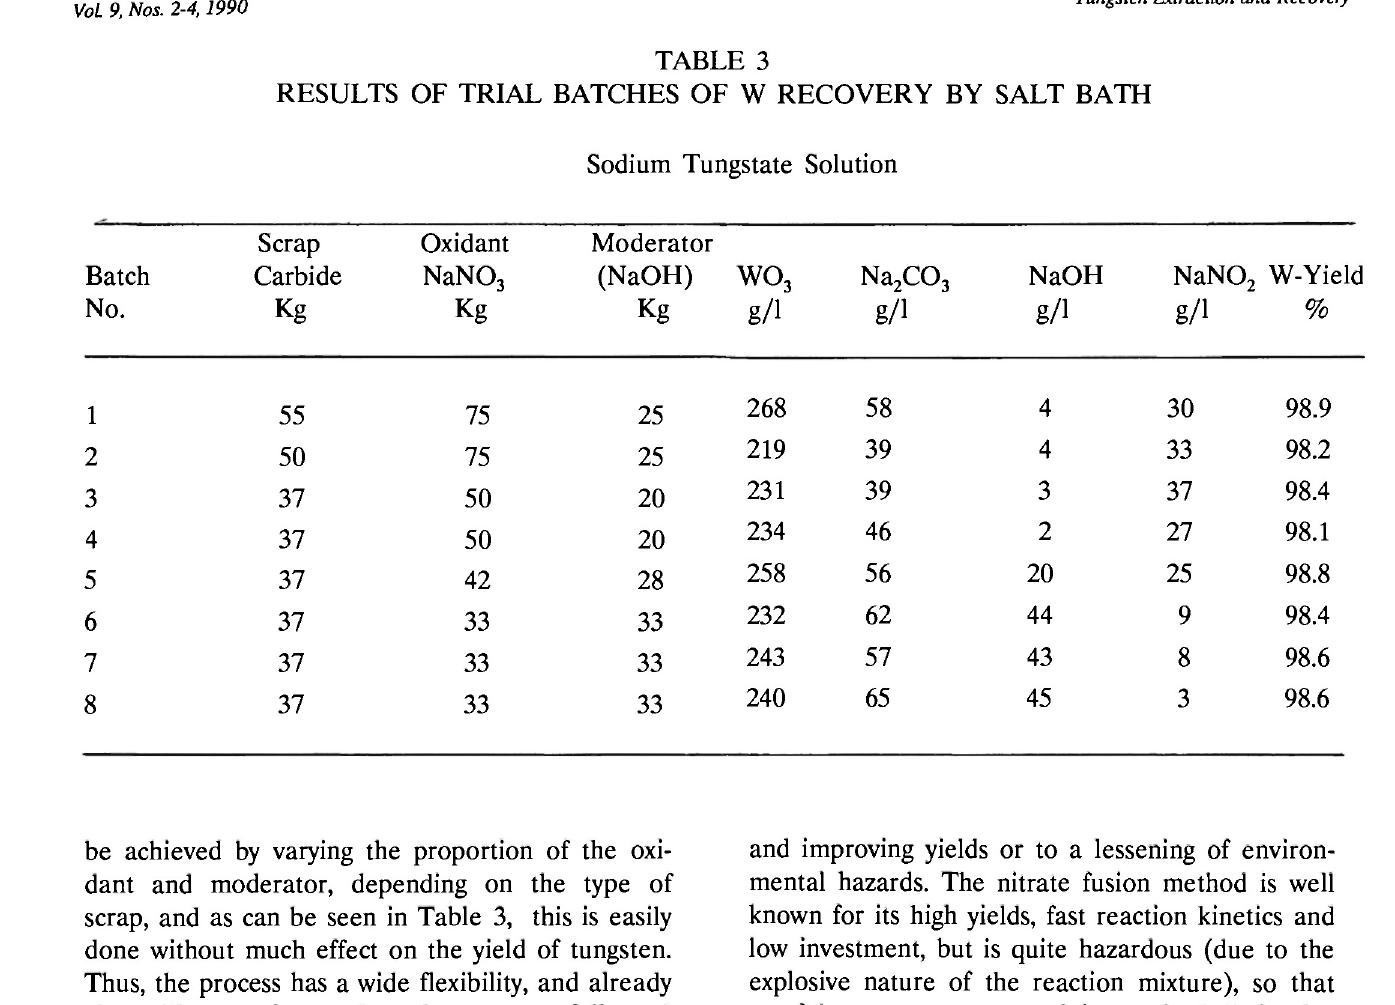
RESULTS OF T R I AL BATCHES OF W R E C O V E RY BY SALT BATH Sodium Tungstate